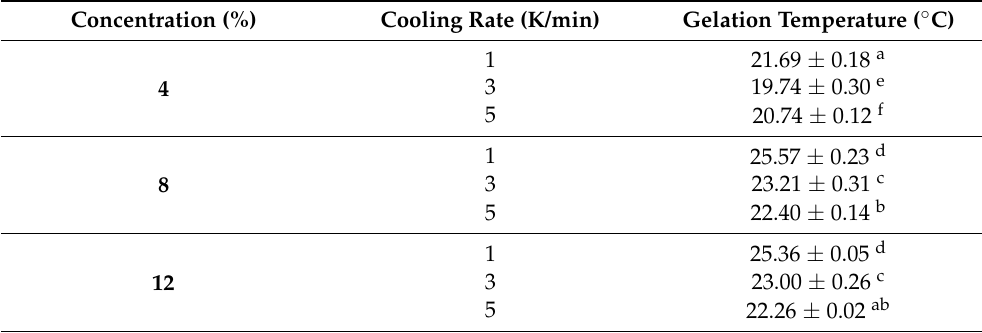
Table 3. Gelation temperature of gelatin at a cooling rate of 1 K/min, 3 K/min, and 5 K/min and interaction coefficients between the cooling rate and the hydrocolloid